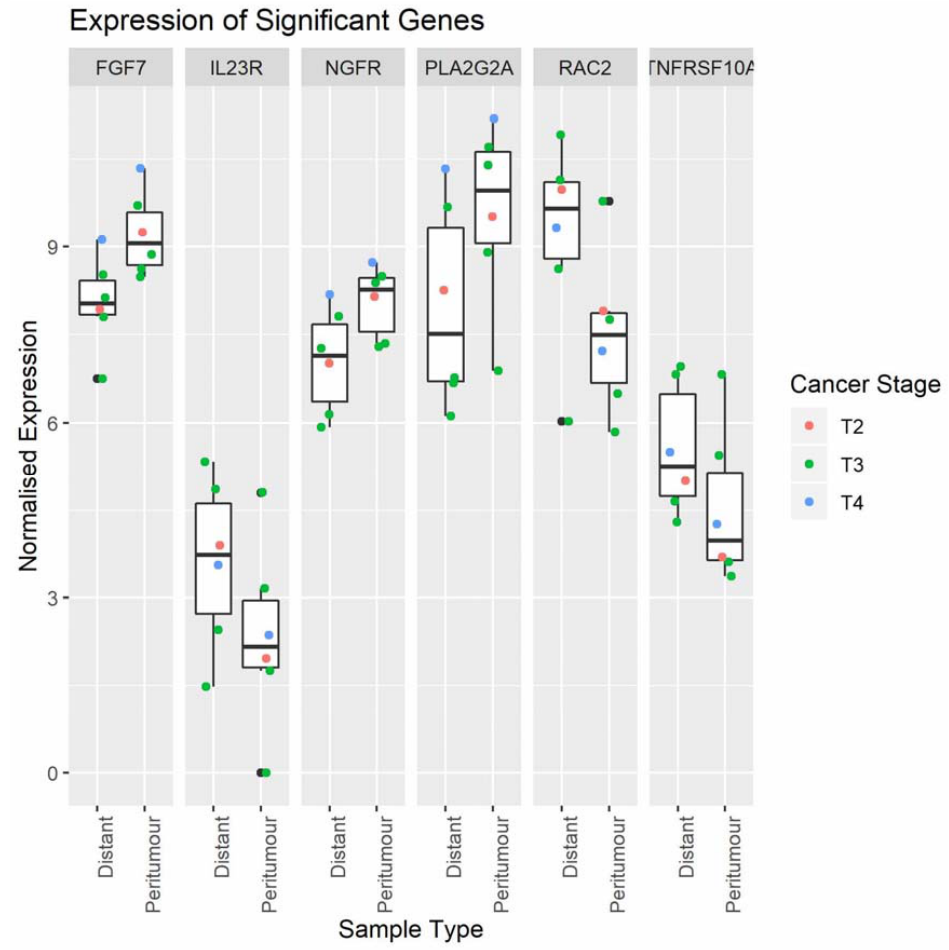
Int. J. Mol. Sci. 2021 , 22 , x FOR PEER REVIEW Figure 2. Boxplots showing normalised expression values for the six most significantly differentially expressed genes.